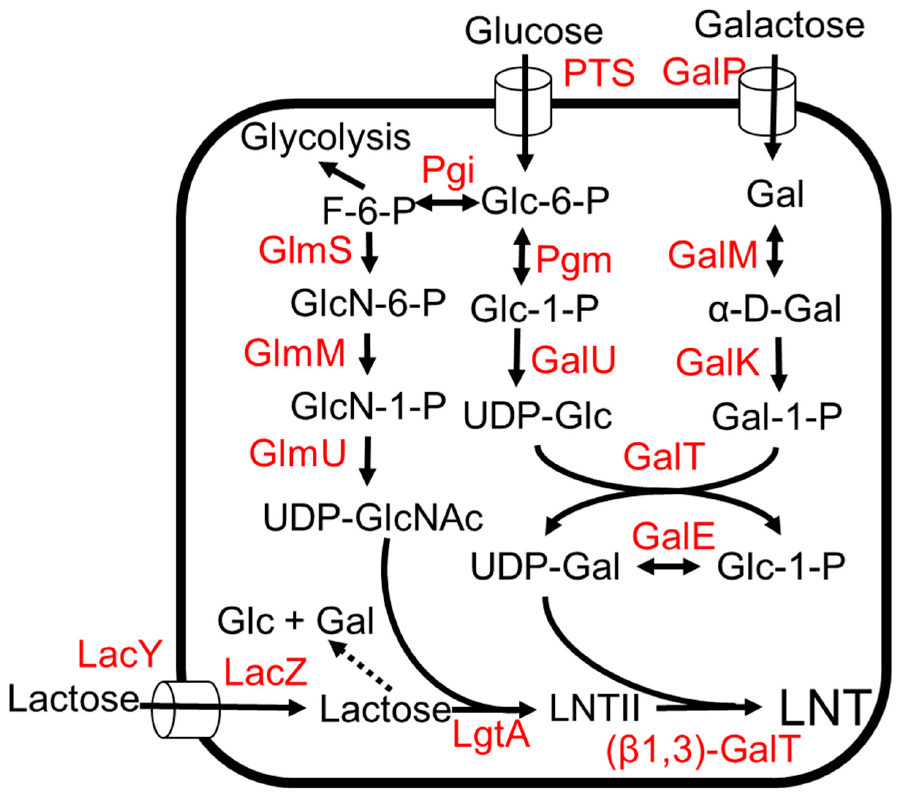
Figure 6. The LNT production from lactose and glucose or galactose. Dotted arrows indicate competing pathways. Abbreviations: PTS, phosphotransferase system; GlmS, L-glutamine—D- fructose-6-phosphate aminotransferase; GlmM, phosphoglucosamine mutase; GlmU, fused N- acetylglucosamine-1-phosphate uridyltransferase and glucosamine-1-phosphate acetyltransferase; Pgi, glucose-6-phosphate isomerase; Pgm, phosphoglucomutase; GalU, UTP—glucose-1-phosphate uridylyltransferase; GalT, galactose-1-phosphate uridylyltransferase; GalE, UDP-glucose 4-epimerase; GalK, galactokinase; GalM, galactose-1-epimerase; GalP, galactose:H + symporter; LacY, lactose permease; LacZ, β -galactosidase; LgtA, ( β 1,3)-N-acetylglucosaminyltransferase; β 1,3-GalT, ( β 1,3)-